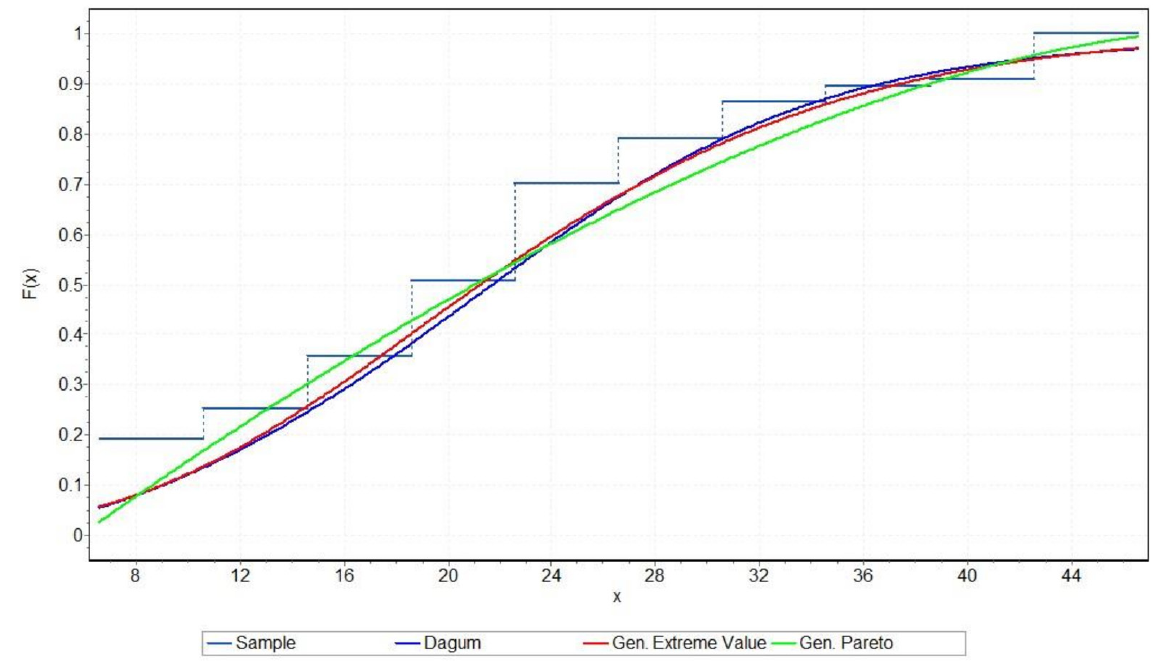
Figure 13. Empirical CDF and the three best fitted three-parameter distributions of the NiTi-1 alloy corrosion rate in the sea